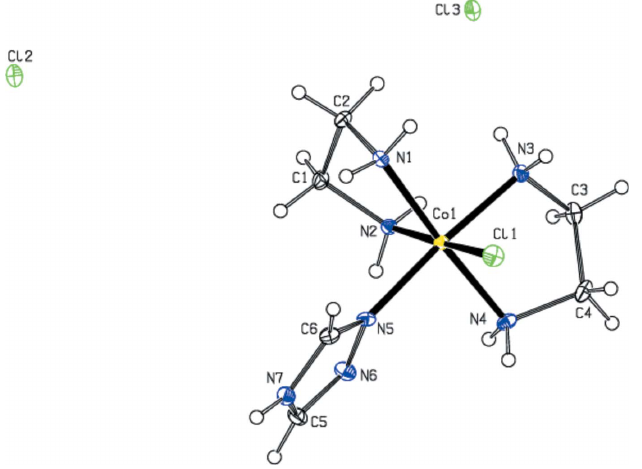
Figure 1 A view of the molecular structure of the title salt, showing the atom labelling. Displacement ellipsoids are drawn at the 30% probability level.